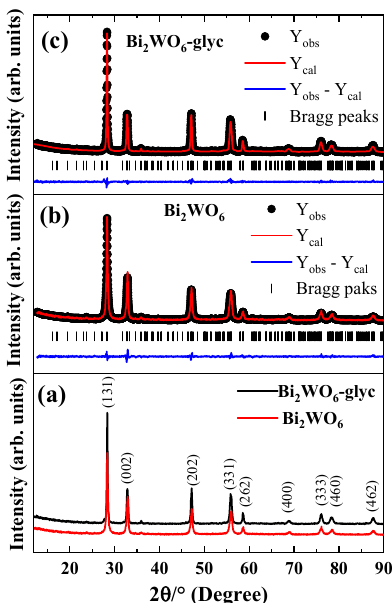
Figure 1. ( a ) XRD patterns of bismuth tungstate synthesized without (Bi 2 WO 6 ) and with the addition of (Bi 2 WO 6 -glyc) glycerol, and Rietveld refinement plots for ( b ) Bi 2 WO 6 and ( c ) Bi 2 WO 6 -glyc.